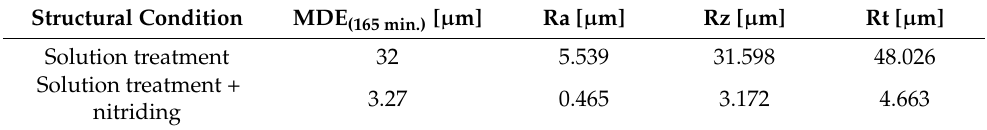
Table 4. Comparative values of roughness and MDE parameters (165 min).